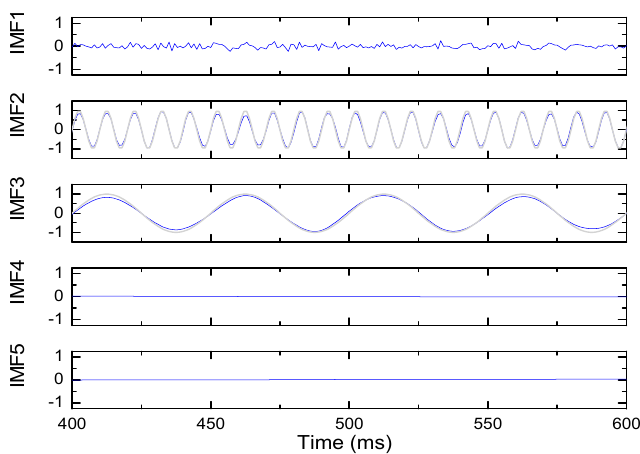
Figure 6. Components obtained by EMD based on the C 2 Hermite interpolation algorithm.